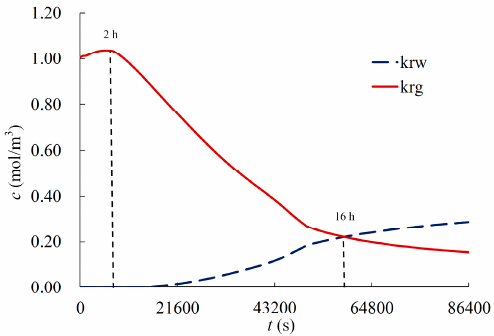
Figure 8. The change curves of gas and liquid relative permeability, k rg and k rw , respectively, with time, t.